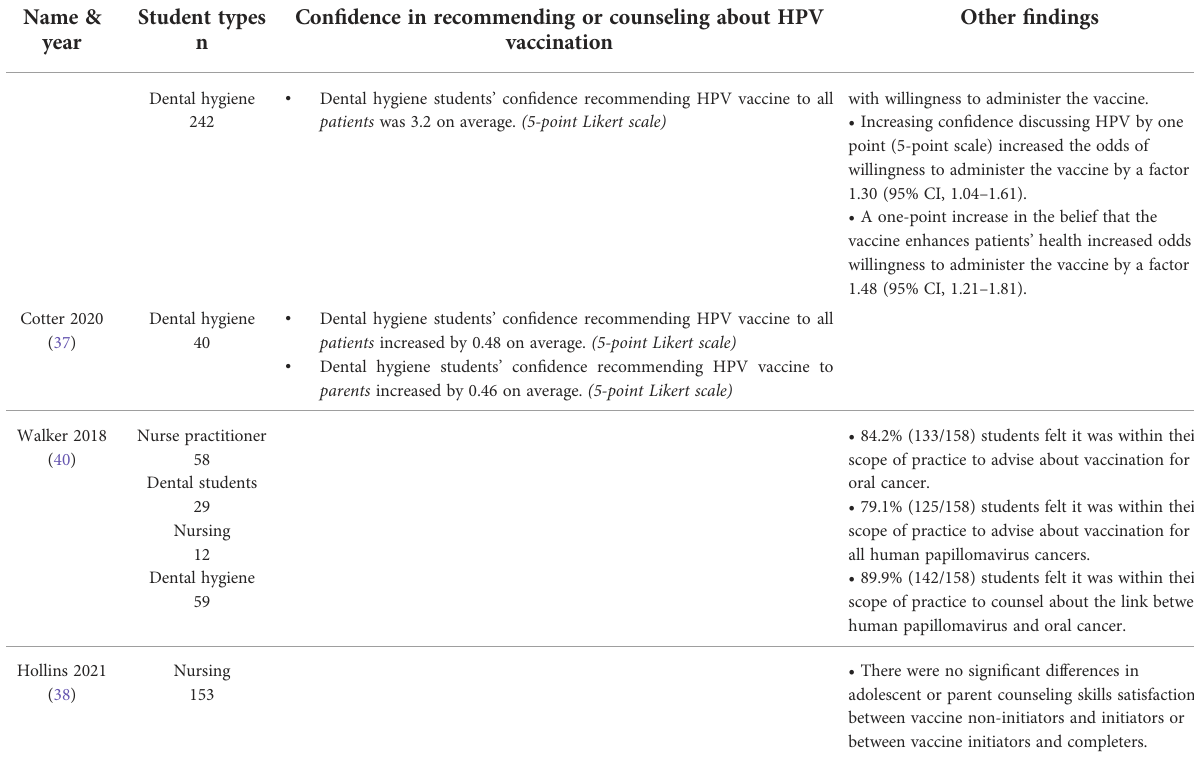
(cid:129) There were no signi fi cant differences in adolescent or parent counseling skills satisfaction between vaccine non-initiators and initiators or between vaccine initiators and